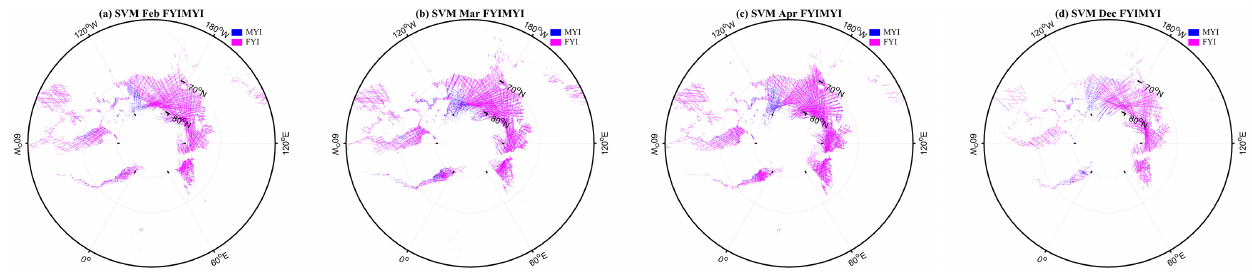
Remote Sens. 2021 , 13 , x FOR PEER REVIEW 26 of 28 Figure A19. SVM for FYI-MYI classification using the data in November as the training set. The data in ( a ) February,